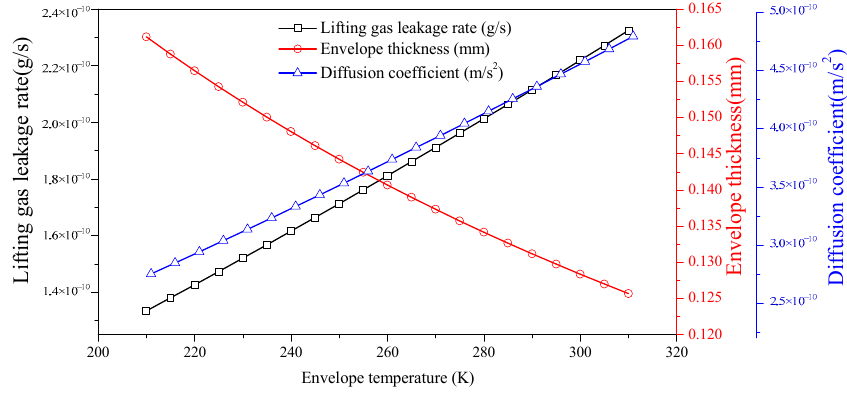
Figure 12. The lifting gas diffusion rate, envelope thickness, and diffusion coefficient.